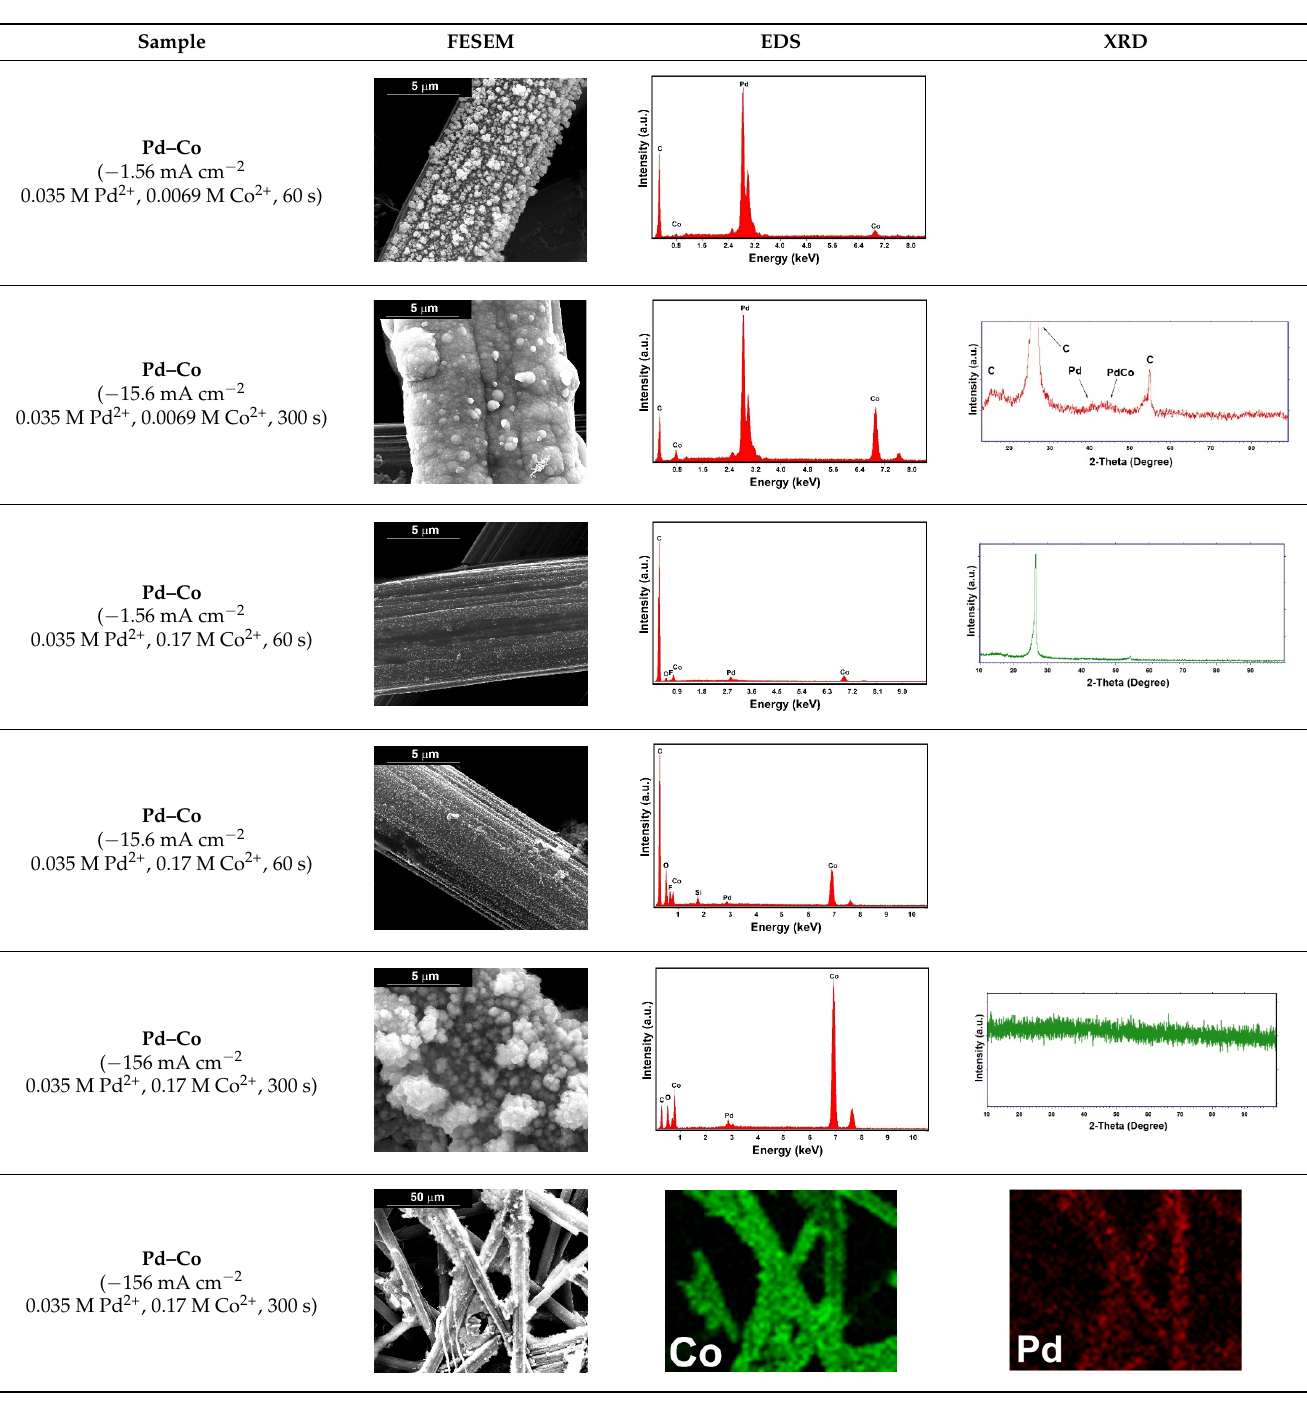
Table 2. The FESEM, EDS and XRD of CP and Pd and Co co-deposits; the electrodeposition conditions and the composition of electrodeposition bath is also reported.